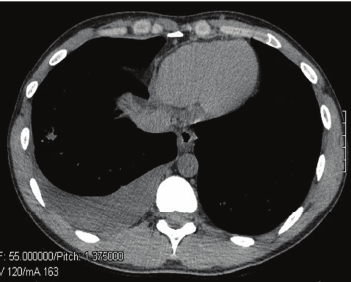
Figure 1: CT scan of the chest showing a 1.1 cm lobular opacity in the right lower lobe and a moderate right pleural e ff usion.